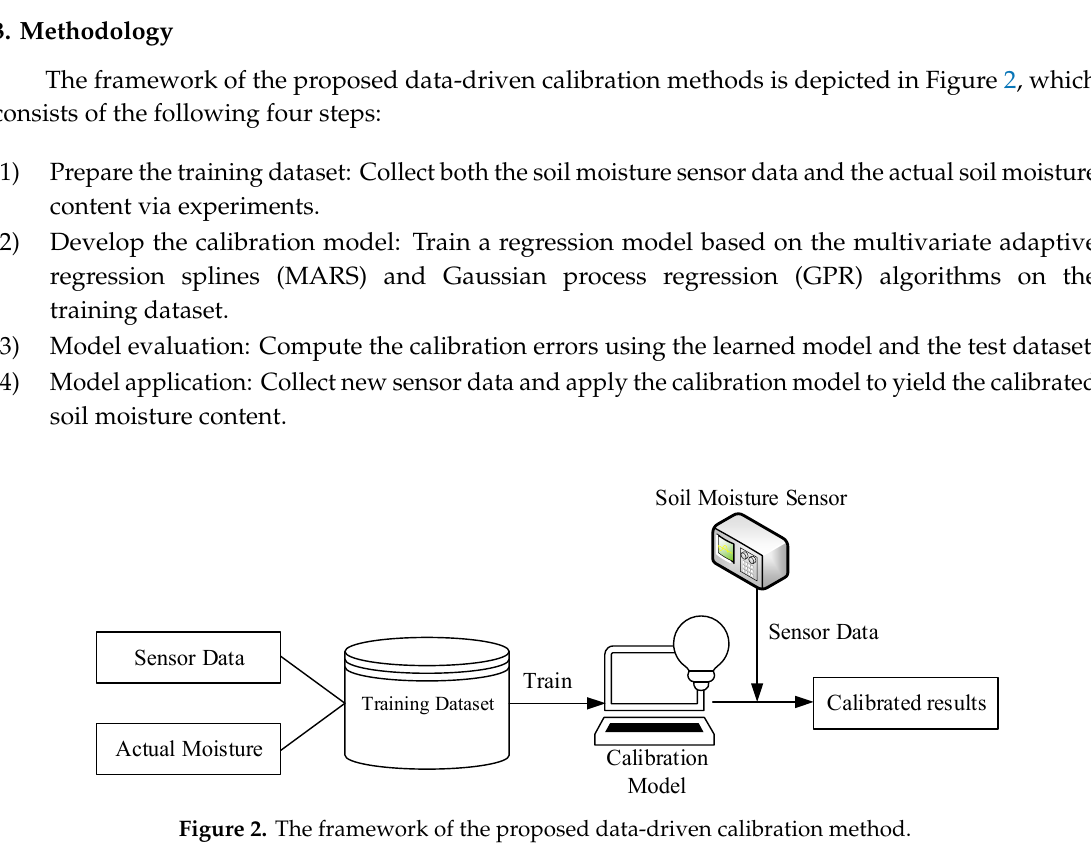
Figure 1. Illustration of sensor readings at various temperatures: ( a ) sensor A; ( b ) sensor B; ( c ) sensor C; and ( d ) sensor D.